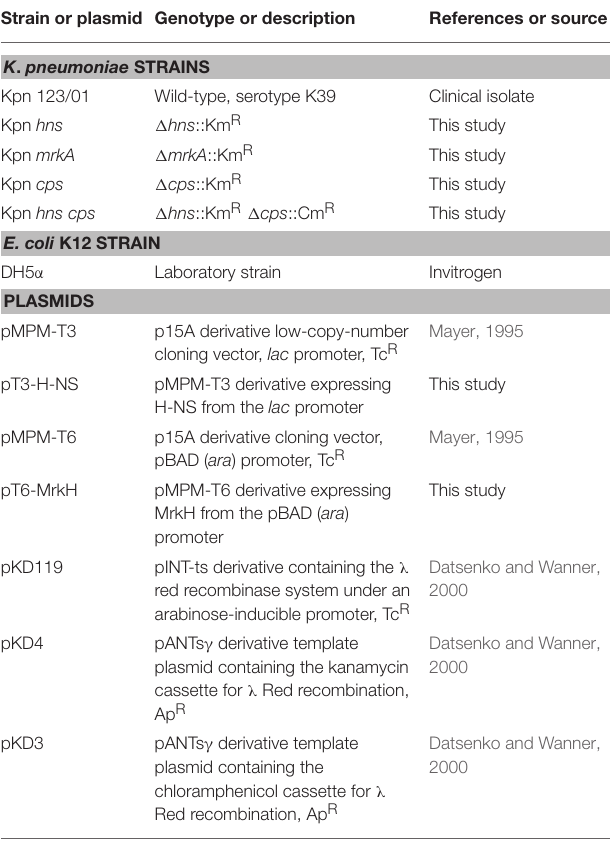
TABLE 1 | Bacterial strains and plasmids used in this study.